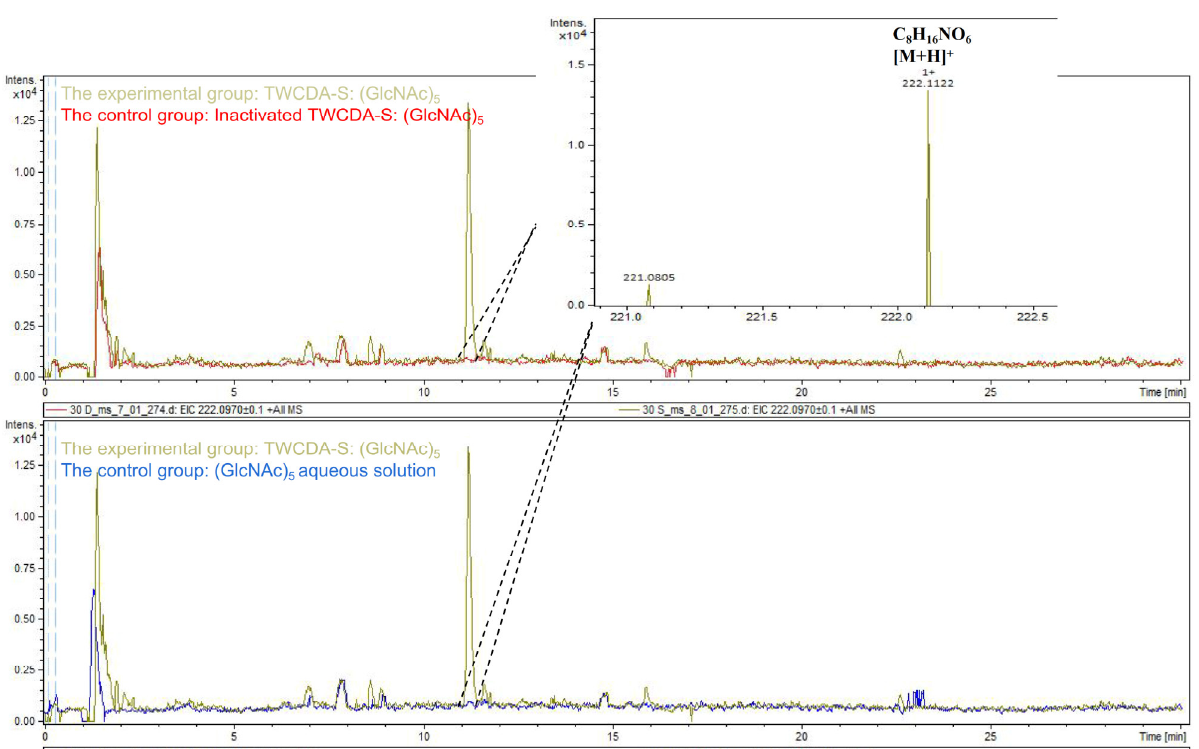
Figure 6. Chitinolytic activity of TwCDAs. ( A ) Enzymatic activities of TwCDA and TwCDA-S with β-chitin as substrate (black bar); enzymatic activities of TwCDA and TwCDA-S with (GlcNAc) 5 as substrate (gray bar); control group (dark graybar and light gray bar). *, p < 0.05; **, p < 0.01. ( B ) Influence of temperature (20–45 °C) on the activities of TwCDA-S with (GlcNAc) 5 as substrate. The error bars are the mean ± SD of three technical replicates for each sample.